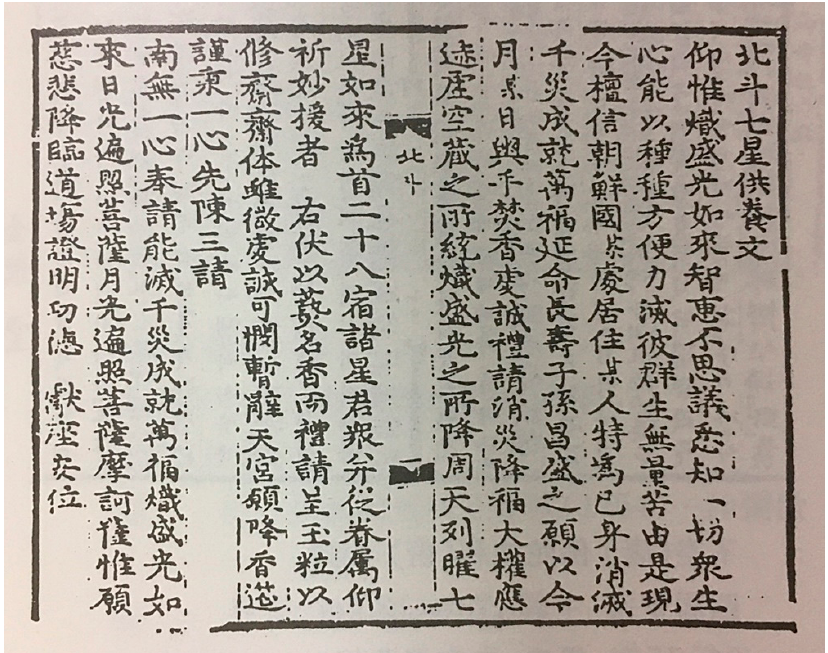
Figure 12. Ritual text for veneration of the Big Dipper (K. Bukduchilseong gongyangmun ), Published at Ssanggyesa Temple, Eunjin, Joseon (1580), 19.2 × 11.5 cm, Gapsa Temple. Source: (Park 1987, p. 179).